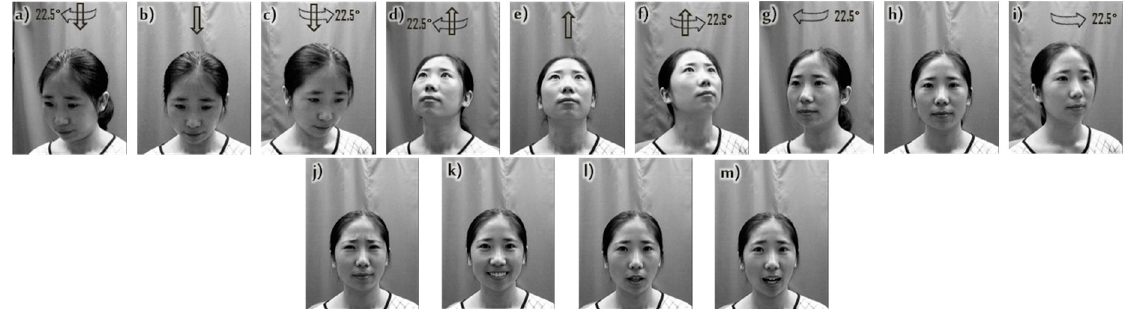
Figure 7. Sample of the CAS-PEAL-R1 database, ( a ) down and rotation to the right, ( b ) down, ( c ) down and rotation to the left, ( d ) up and rotation to the right, ( e ) up, ( f ) up and rotation to the left, ( g ) rotation to the right, ( h ) frontal, ( i ) rotation to the left, ( j ) frown, ( k ) smile, ( l ) open mouth, ( m ) surprise.